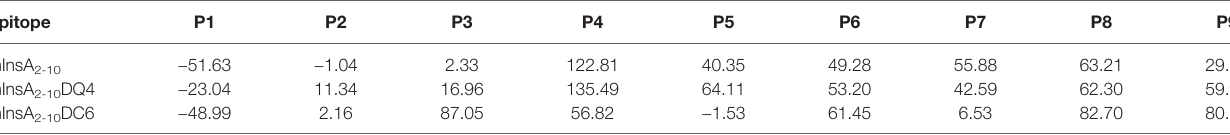
TABLE 2 | The solvent accessible surface area (SASA) of residues of epitopes.